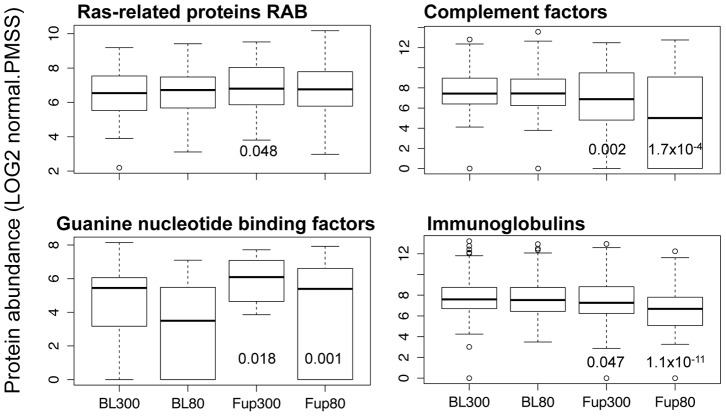
MP Protein quantification by label-free proteomics.Expression levels (LOG2 values of normalized protein abundance values) of cellular signaling proteins (left side) and proteins involved in the innate immune response (right side) are shown in boxplot format. RAS-related proteins RAB encompass RAB1B, RAB5C, RAB6B, RAB7A, RAB8A, RAB10, RAB11B, RAB15, RB27B, RAB35, RAP1B, and RAP2B, identified in all twelve analyzed MP samples. Guanine nucleotide binding factors encompass GNA13, GNAI2, GNAQ, GNAZ, GBB1, and GBB2, identified in at least eight MP samples. Complement factors considered were identified in at least eight MP samples: C1QA, C1QB, C1QC, C1R, C1S, CO2, CO3, CO4A, CO4B, CO5, CO6, CO7, CO8B, CO8G, CO9, and CFAB. All immunoglobulin heavy and light chains identified in at least 10 MP samples were considered. When one of the proteins was not identified its value was set at zero for statistical analysis of P values. P values are given below each box if the likelihood for a statistical difference between BL and Fup was at least 95%.